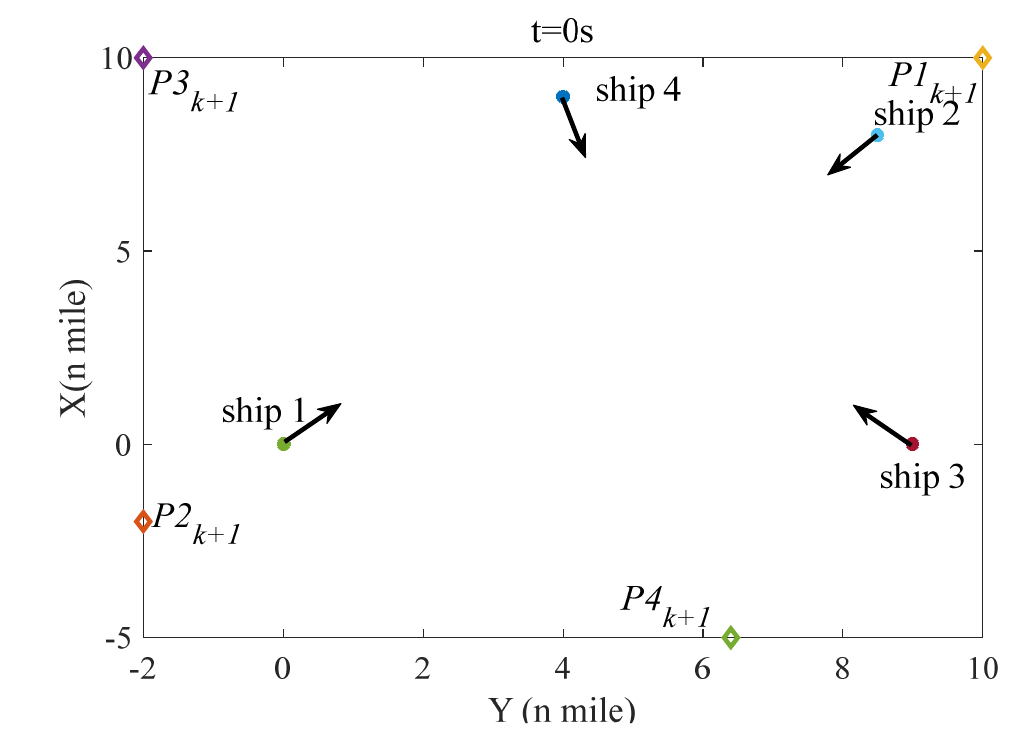
Figure 6. The initial situation of four ships in scenario 1 .